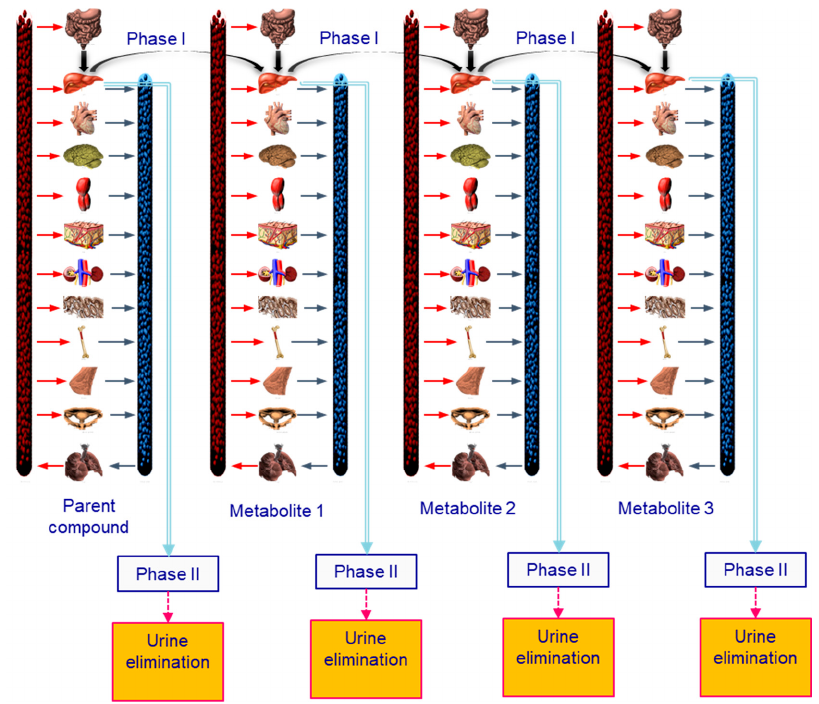
Figure 1. Conceptual representation of the generic Physiology-Based BioKinetic (PBBK) model.